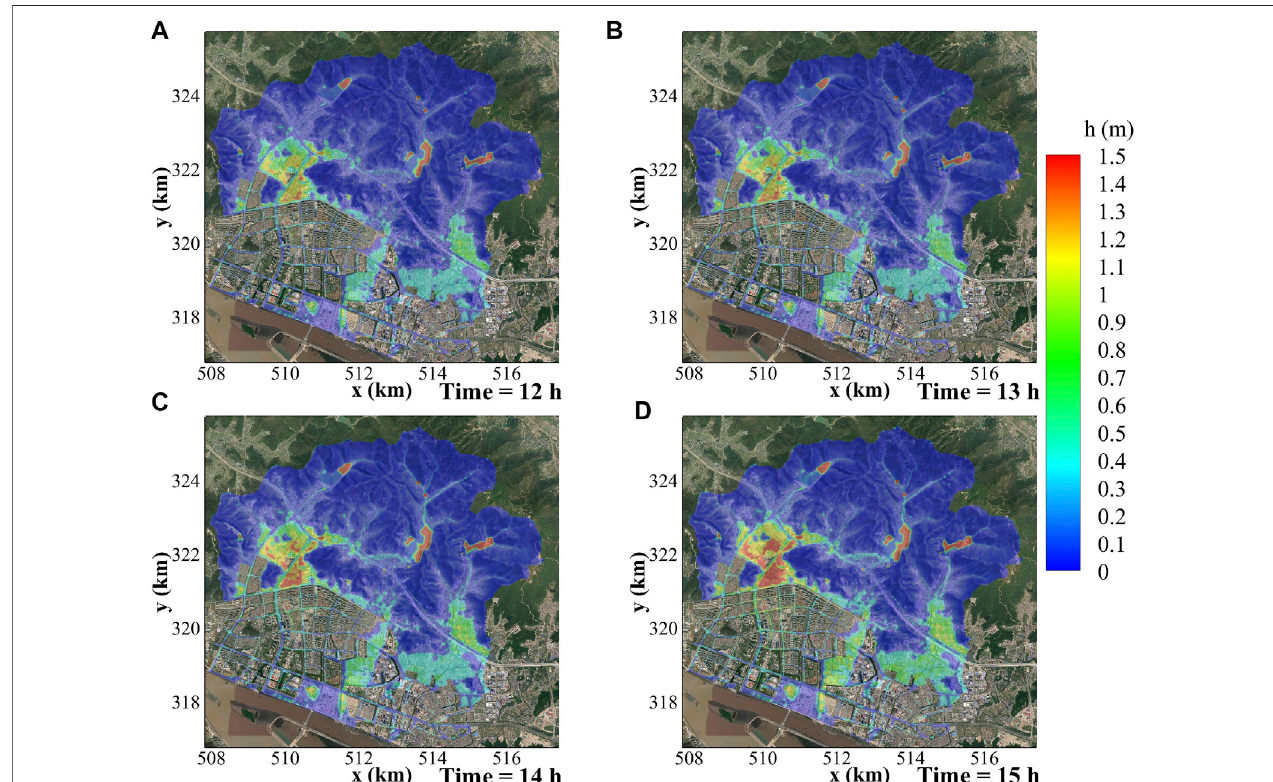
FIGURE 5 | Temporal and spatial evolution of water depth for CSWM in Case 2 at (A) 12 h, (B) 13 h, (C) 14 h and (D) 15 h.